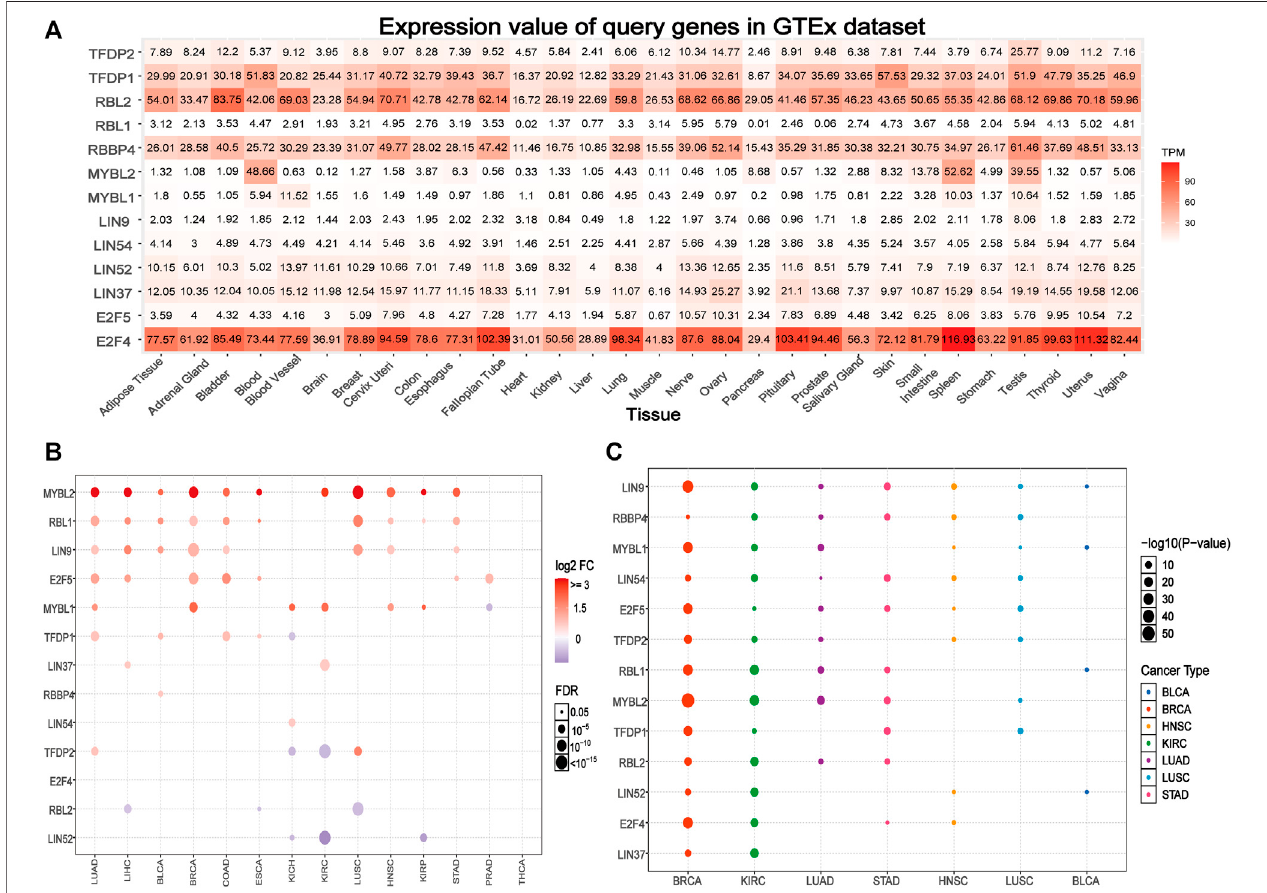
FIGURE1| GeneexpressionoftheDREAMcomplex. (A) Heatmapoftheexpressionpro fi lesoftheDREAMcomplexintheGTExdataset. (B) DifferencesinmRNA levels between normal samples and adjacent cancers. (C) The expression of subtypes of the DREAM complex in tumors.